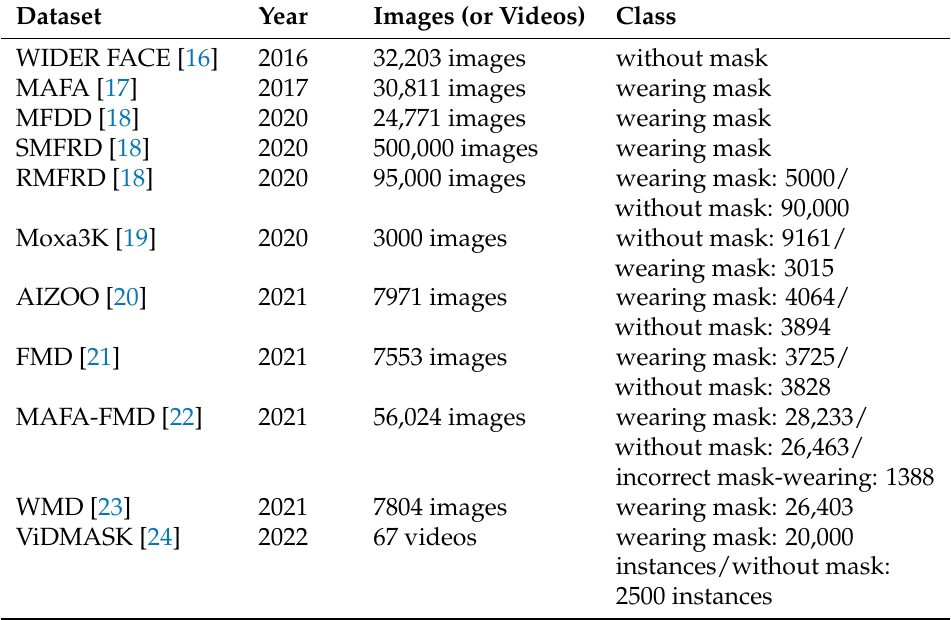
Table 1. Common datasets for mask-face